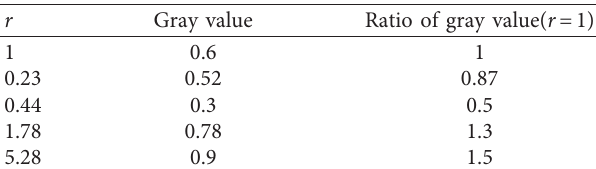
Figure 9: Comparison of the experimental results. Gray values of a target region for Figures 8(d), 8(f), 8(h), 8(j), and 8(l) as a function of pixel position, in which the dashed line indicates the gray value distribution of the imaging target. Table 1: The ratio of gray value of different r value and gray value when r �